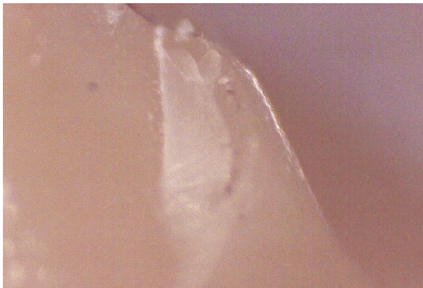
Figure 9: Stereomicroscopic images of the fractured crowns showing cohesive mode of failure at 35x